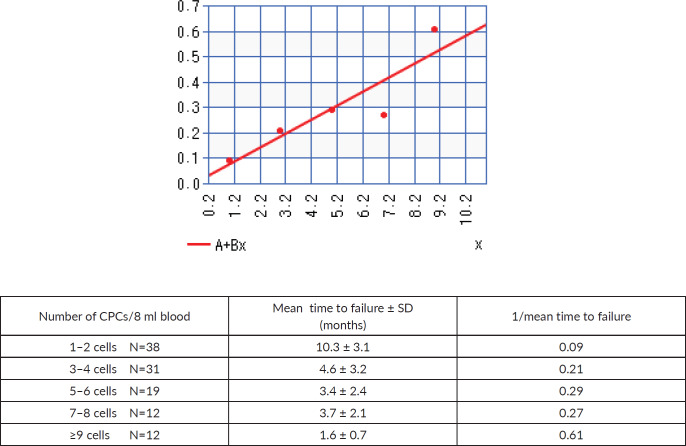
Linear regression comparing the number of CPCs detected versus 1/time to biochemical failure.